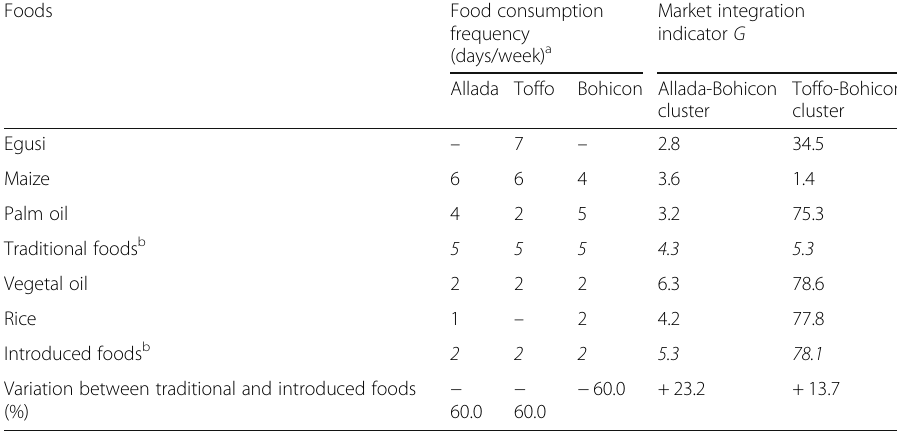
Table 6 Food consumption frequency and composite market integration index in Allada-Bohicon and Toffo-Bohicon market clusters